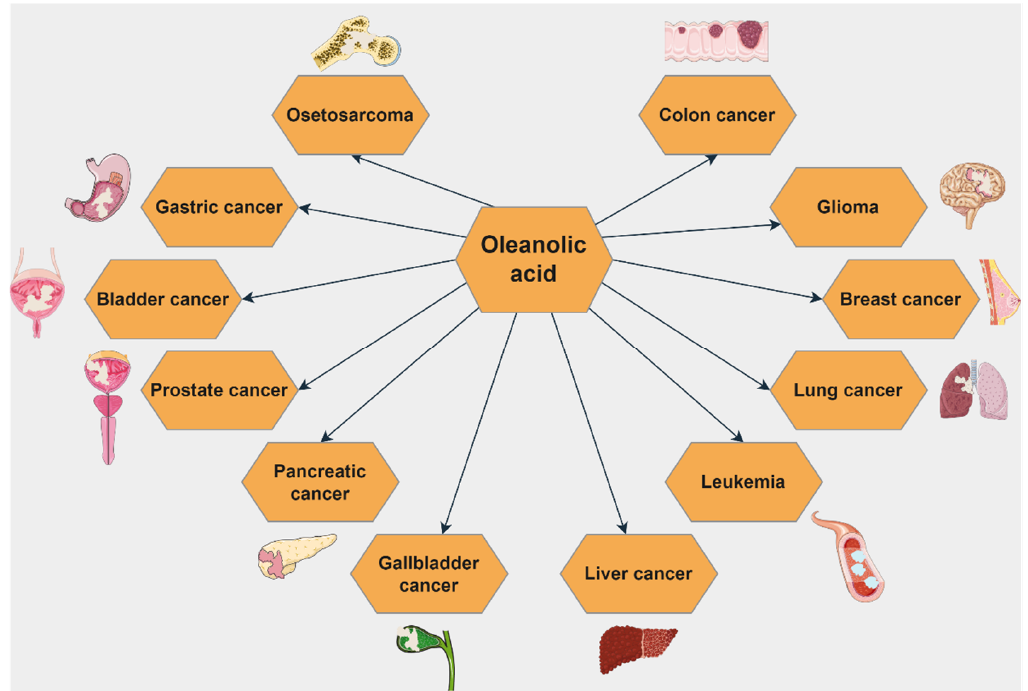
Figure 9. Anticancer effect of oleanolic acid in various types of cancer.